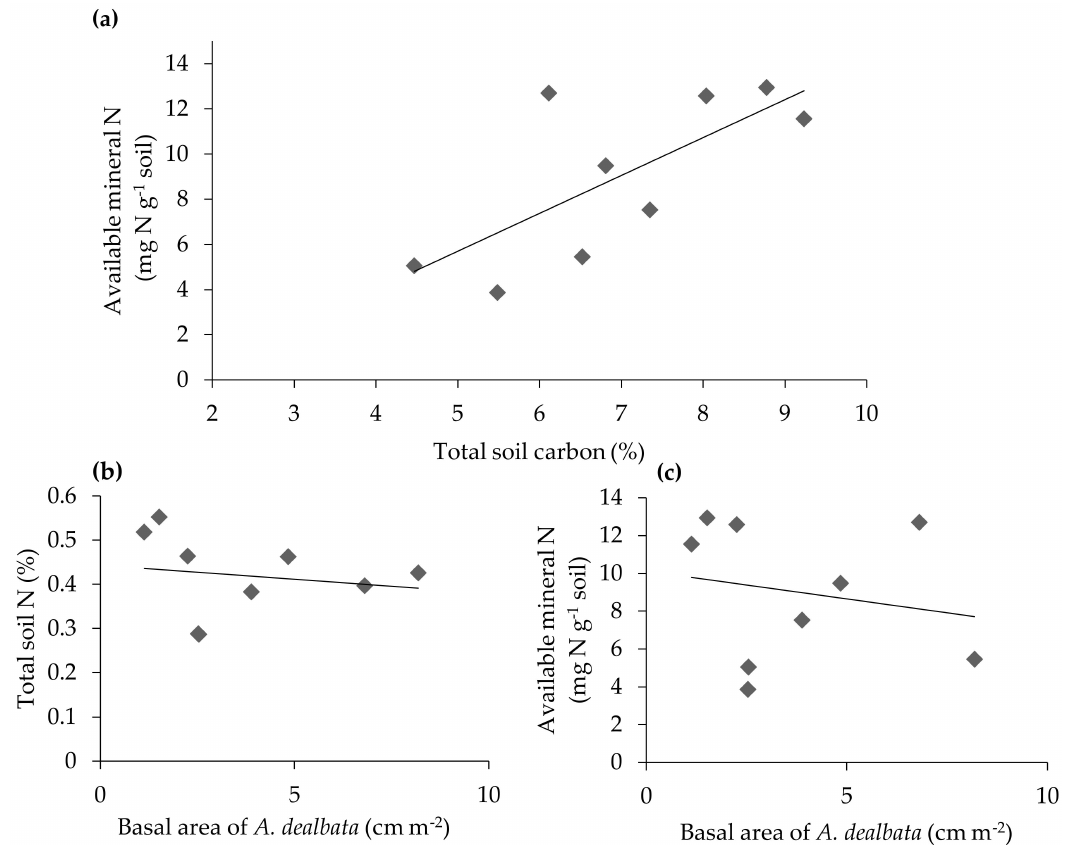
Figure 1. Relationship between total basal area of A. dealbata and the amount of nitrogen at each soil site in two di ff erent forms: ( a ) Relationship between total soil carbon (%) and available mineral nitrogen (N). Concentrations are determined from soil collected from each of the nine sites in a eucalypt forest. ( b ) Total soil organic matter quantity in terms of total soil nitrogen (%) and the total basal area at each soil site and ( c ) Available mineral N present at each site and the relationship to total basal area of A. dealbata